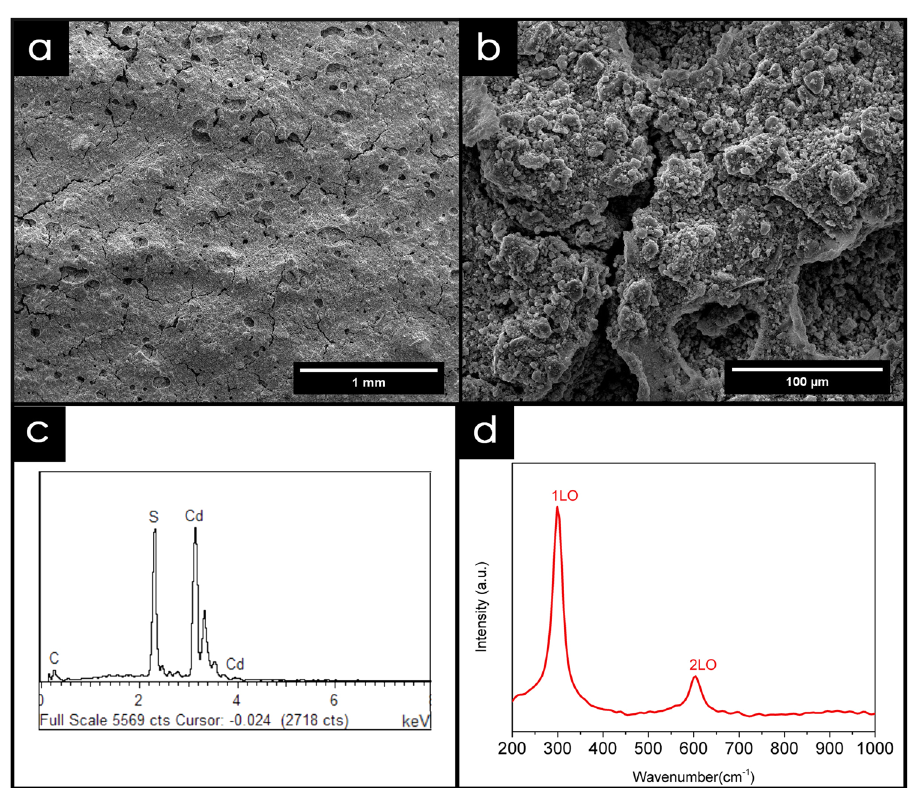
Figure 6. Characterization of CdS nanoparticles. ( a ) FESEM image and ( b ) magnified image of CdS deposited 3DE/Au electrode surface. Corresponding ( c ) EDX and ( d ) Raman analysis of the CdS